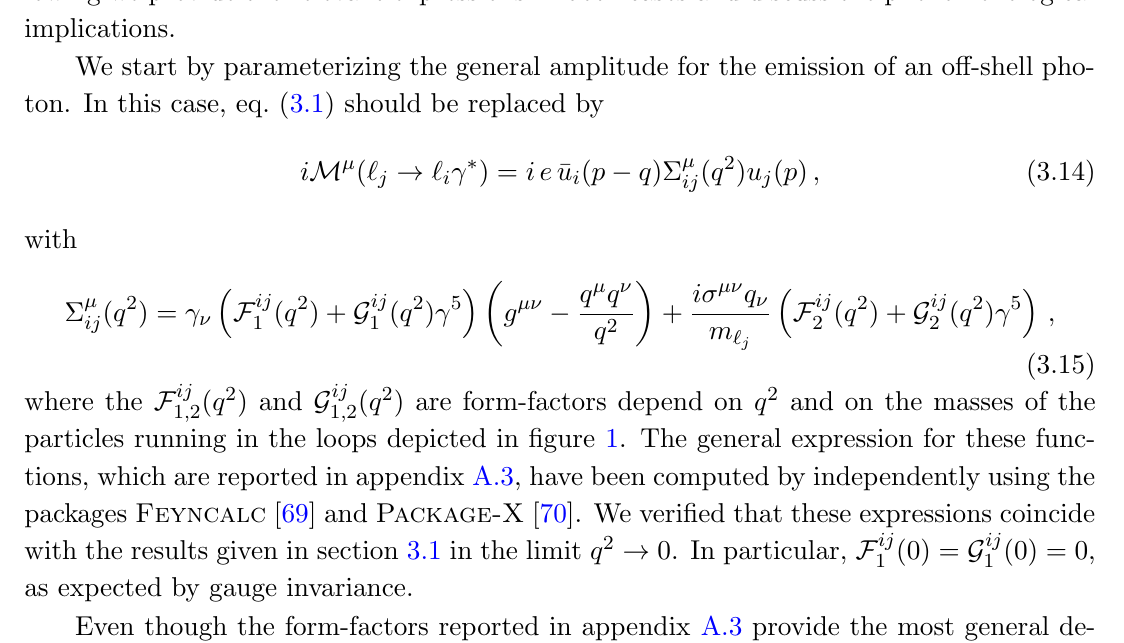
Figure 2 . Diagrams illustrating the ALP contributions to ‘ j and tree-level (right panel). The gray blob in the photonic contribution represents the di(cid:11)erent loop contributions illustrated in (cid:12)gure